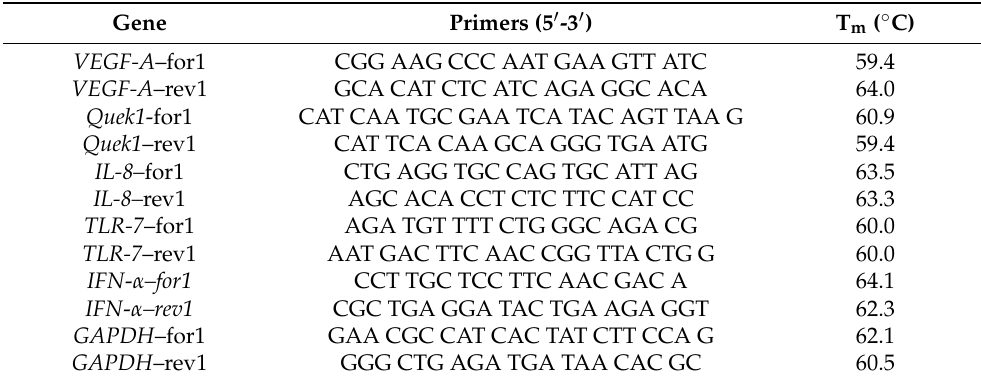
Table 1. The primer sequences and amplified